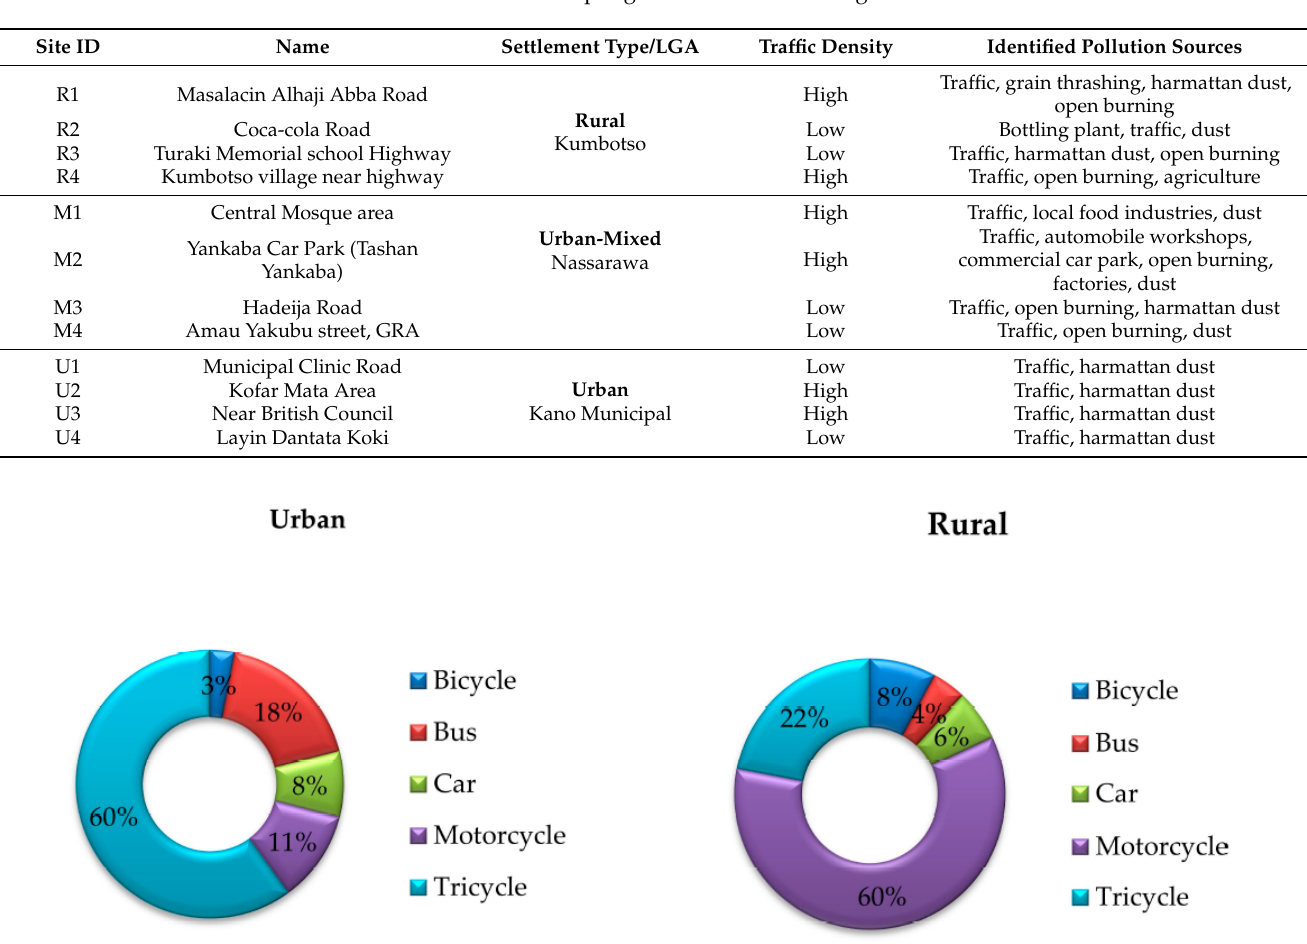
Table 1. Details of air sampling sites in Kano State-Nigeria.